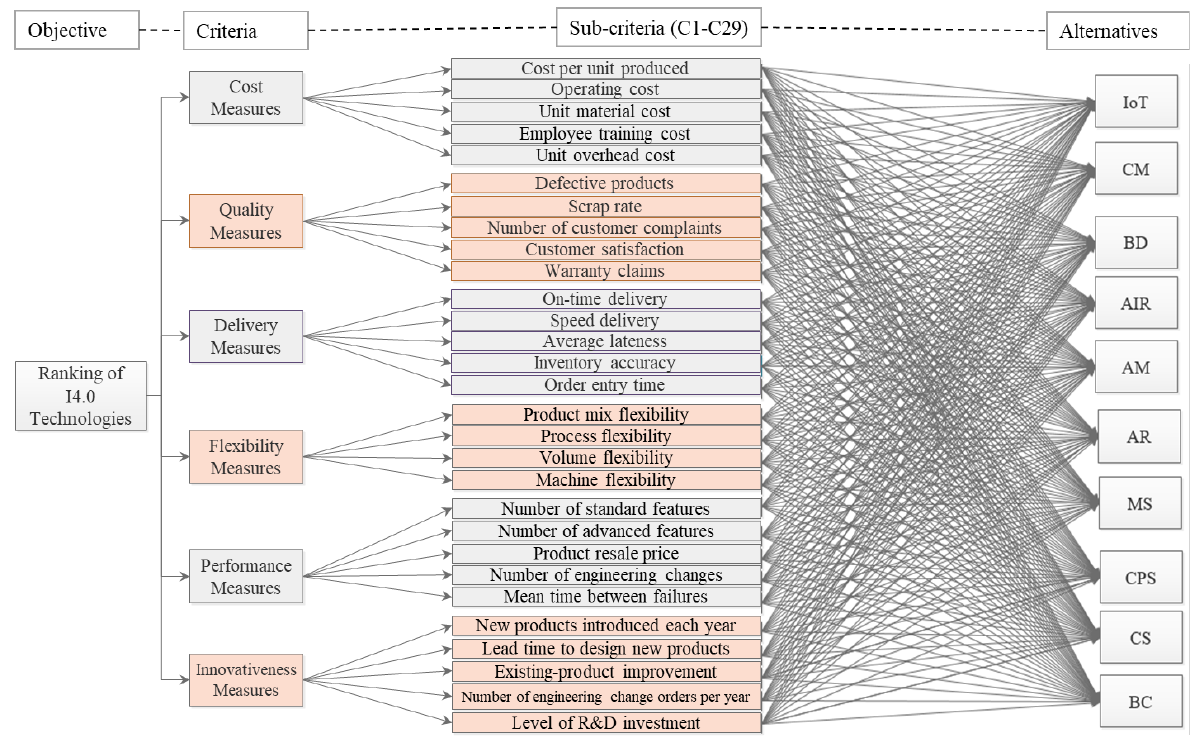
Figure 4. Decision-making hierarchy to rank I4.0 technologies.